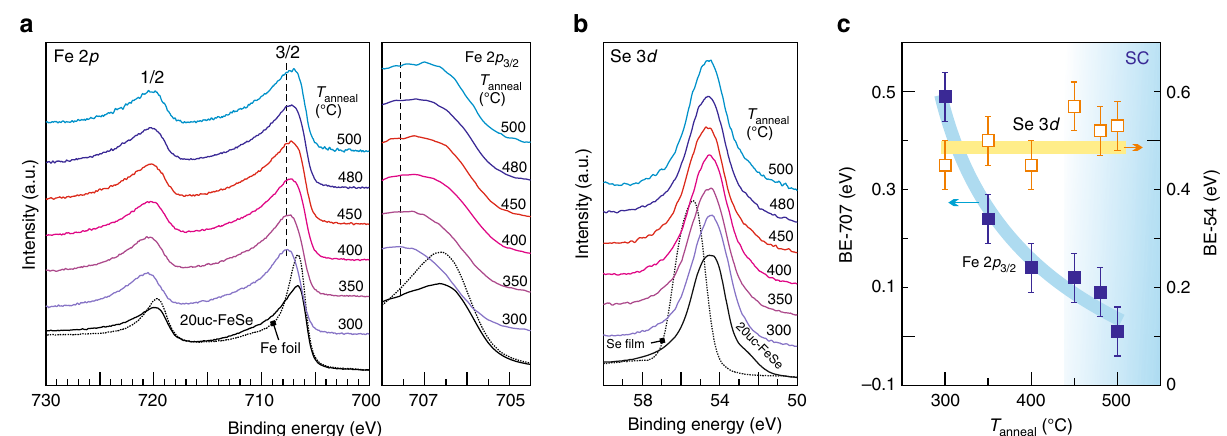
Fig. 3 Fe 2 p and Se 3 d core-level spectra of 1uc-FeSe/STO. Bottom curves in the left panel of a (the main panel of b ) are reference spectra of 20uc-FeSe/ STO and a Fe foil (a 20 nm thick Se fi lm). The Fe foil has been repeatedly sputtered and annealed to ensure the removal of oxidized layers. ( c ) Summary of the peak positions of Fe 2 p 3/2 and Se 3 d at different annealing stages. The peak positions of Fe 2 p 3/2 are extracted from the Gaussian – Lorentzian fi tting after subtracting the Shirley background (Supplementary Fig. 8). The peak positions of Se 3 d are obtained from the corresponding energy values of